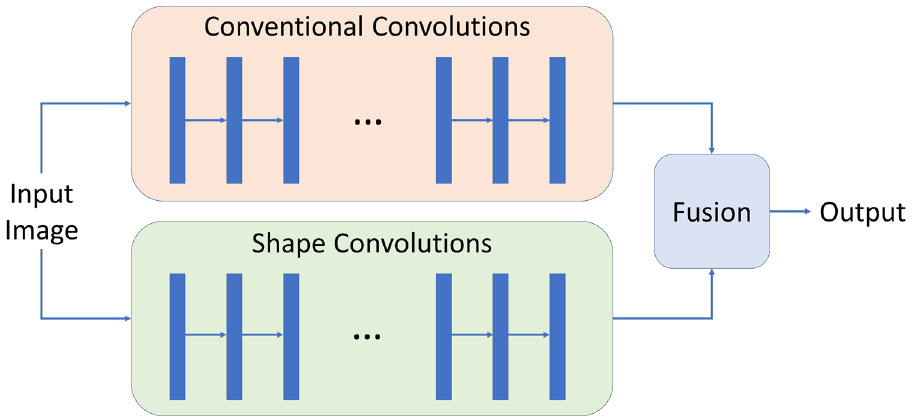
Figure 5. An illustration of the idea of multi-stream model that recognize pixels intensities and shape information separately. To predict segmentation masks, the output tensors from both streams can be fused using carefully designed concatenation layers or multi-scale pooling